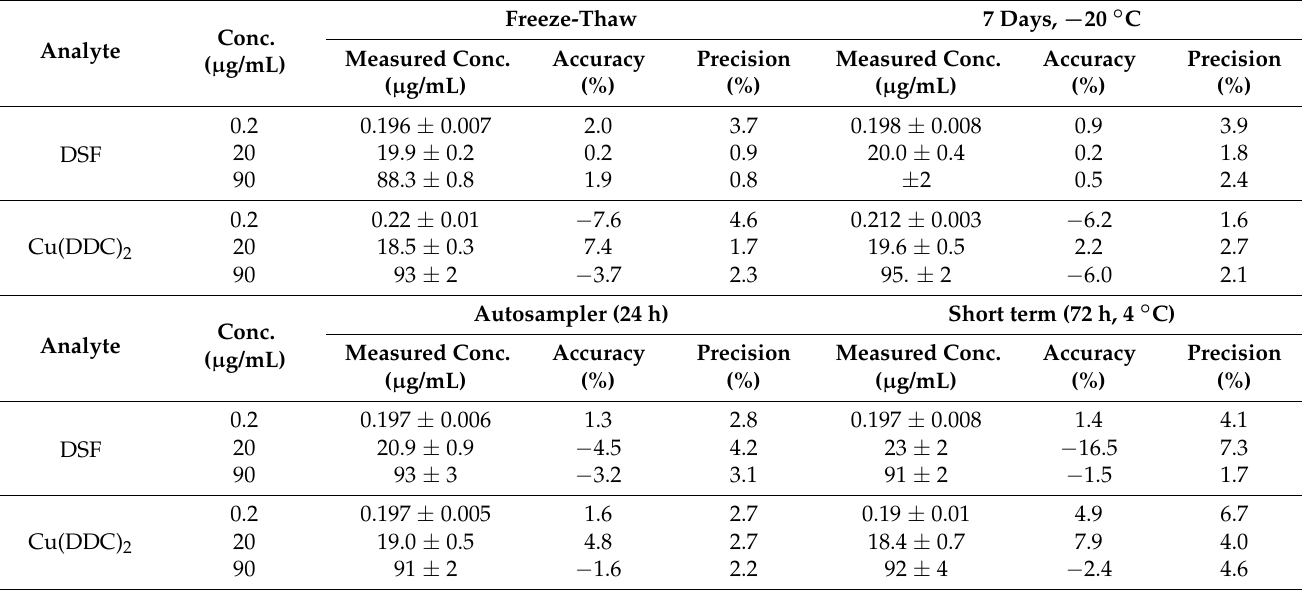
Table 10. Stability studies of quality control solutions (n = 6) in different conditions (stock: freeze-thaw and 7 days at − 20 ◦ C; quality controls: autosampler, 24 h and 72 h at 4 ◦